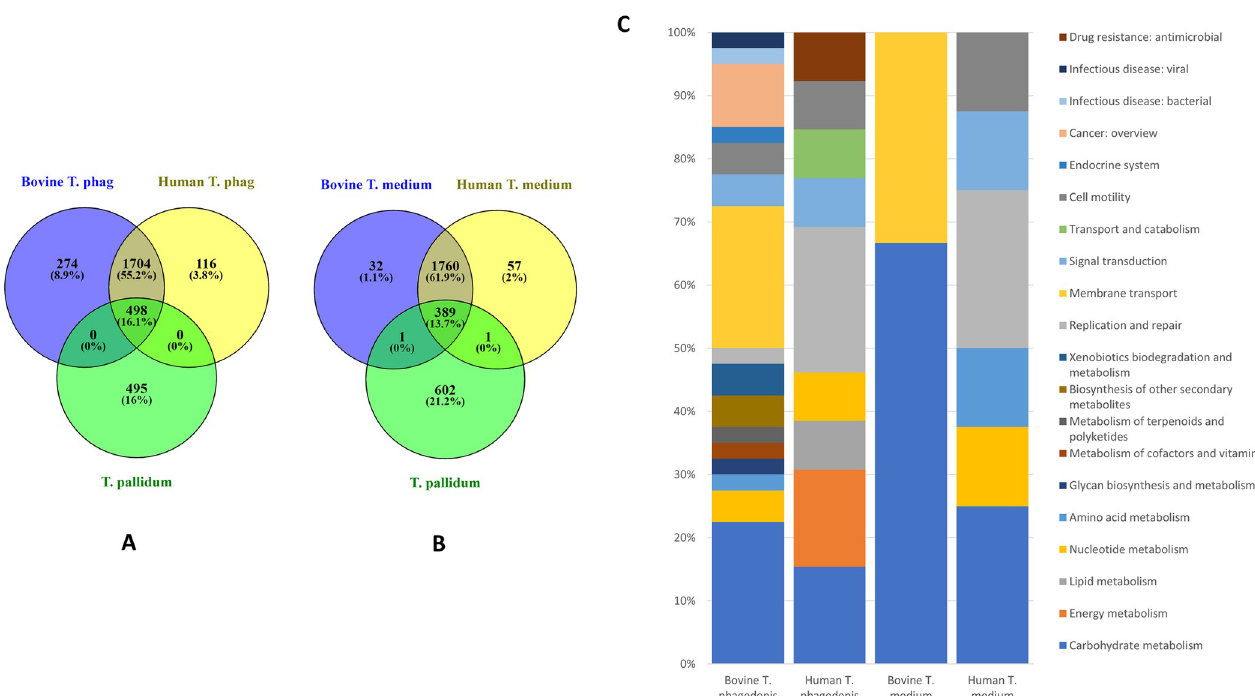
Fig 3. Core, accessory and unique genes shared between bovine pathogenic and human saprophyte Treponema phagedenis strains and Treponema pallidum or between bovine and human pathogenic Treponema medium strains and T . pallidum . Venn diagram representation of the core, accessory and unique genes shared between bovine pathogenic and human saprophyte T . phagedenis strains and T . pallidum (A) : Core, accessory and unique genes shared between bovine and human pathogenic T . medium strains and T . pallidum (B) . Numbers of shared gene families and/or unique genes are listed with the percentage of the total pan-genome this represents (for each comparison) listed in parentheses. C: Functional classification of genes unique to bovine and human T . phagedenis or bovine and human T . medium . Only genes that could be assigned a KEGG category are represented in the bar graphs. Only 27 (23.3%) of the 116 unique genes from human T . phagedenis could be annotated, only 68 entries (24.8%) of the 274 unique bovine T . phagedenis genes could be annotated. Only 16 (28.1%) of the 57 unique genes from human T . medium could be annotated, only 4 entries (12.5%) of the 32 unique bovine T . medium genes could be annotated.